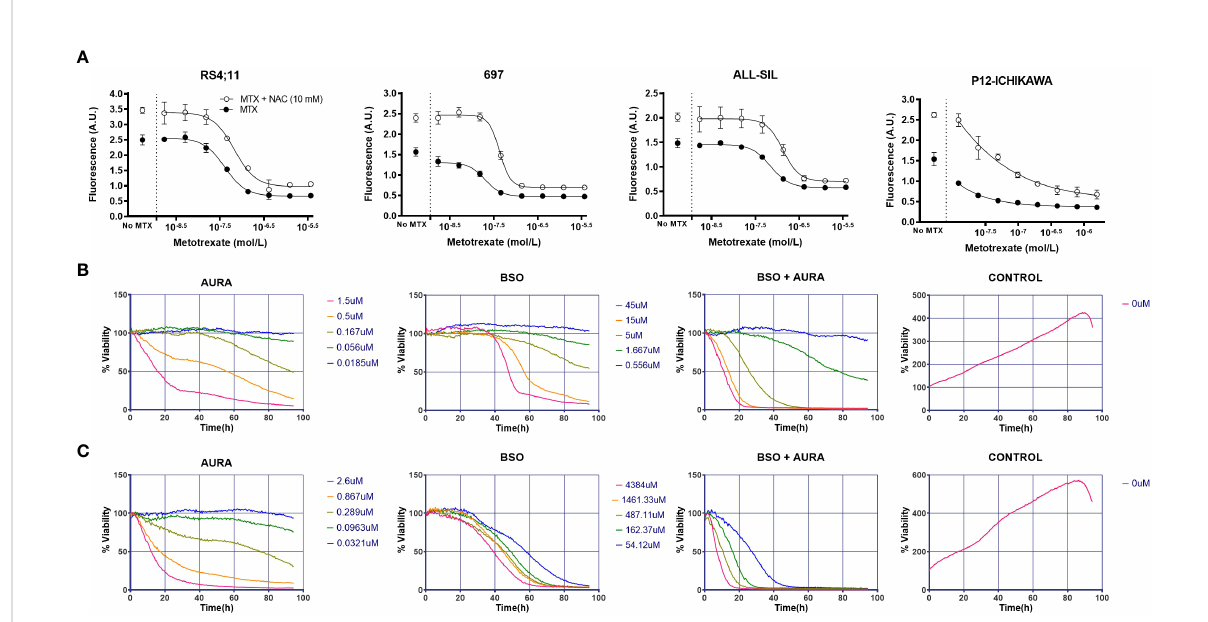
FIGURE 4 In vitro combination of GSH pathway modulators with MTX or a thioredoxin reductase inhibitor. (A) Survival curves to increasing doses of MTX in either the presence or absence of NAC in four representative cell lines, accessed by the calcein AM method after 96 hours of treatment. A.U. = arbitrary units. (B) BCP-ALL RS4;11 survival in response to aurano fi n (AURA), buthionine sulphoximine (BSO), BSO + AURA and vehicle (CONTROL) accessed by bright fi eld imaging (high-throughput drug combination screening assay) over 96 hours. (C) Idem (B) , for TALL-1 cell line. In the BSO + AURA plots, curve colors indicate the corresponding doses of the single agents that were